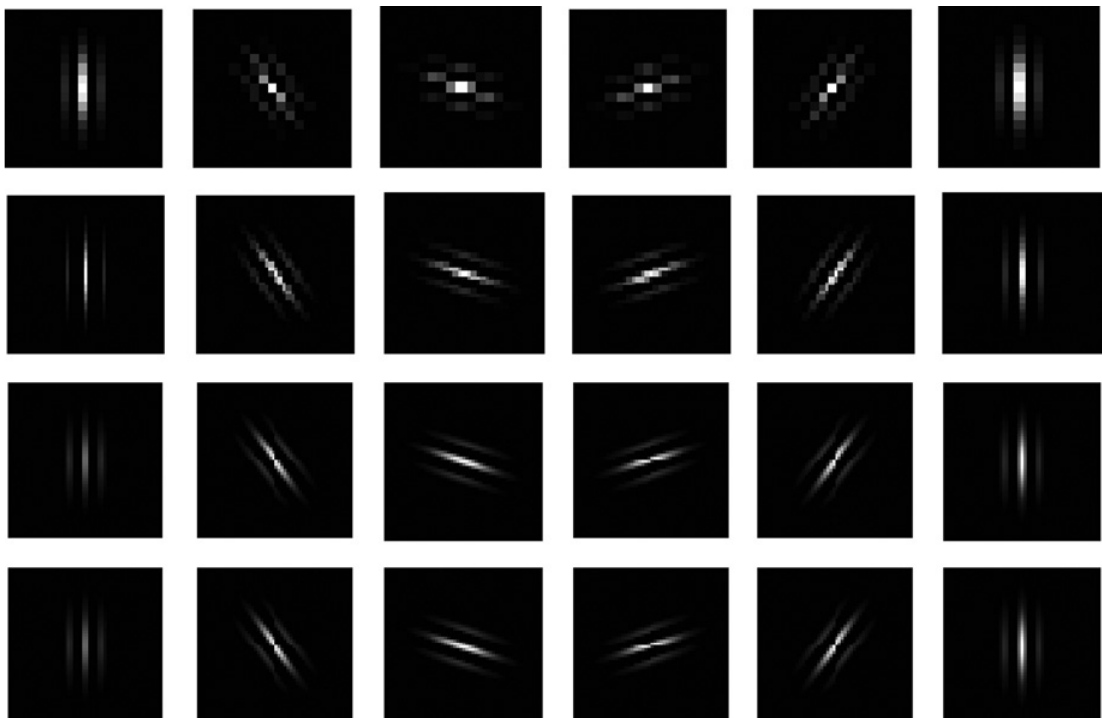
Figure 5: 2D Plot of Gabor Filter with Various Values of Theta and Spatial Frequency.